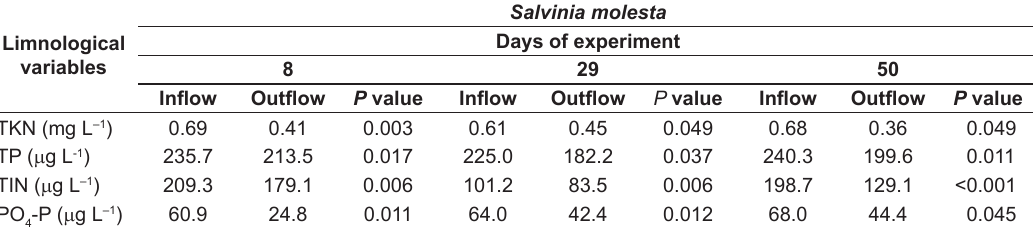
Table 2. Mean nitrogen and phosphorus concentrations in the inflow and outflow of tanks with Salvinia molesta resulting from the T-test.